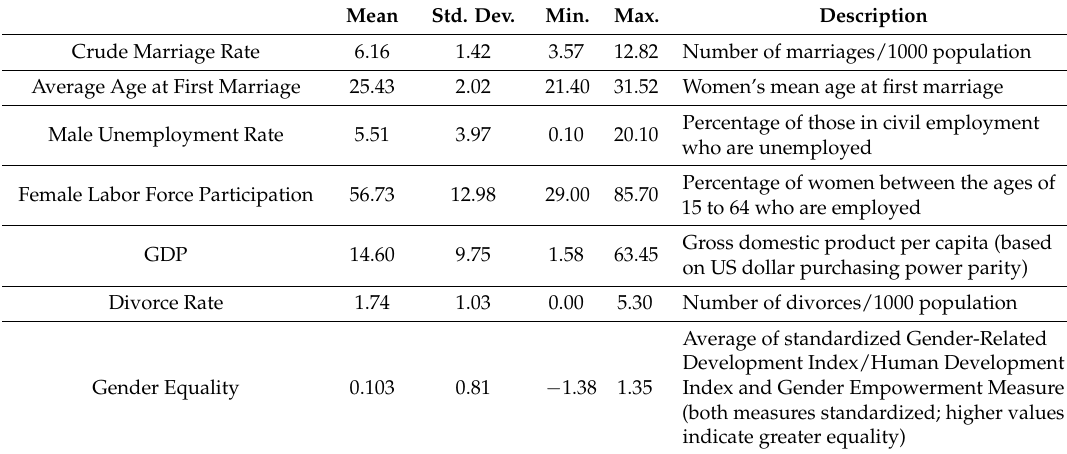
Table 2. Summary Statistics (N = 707 country years 1